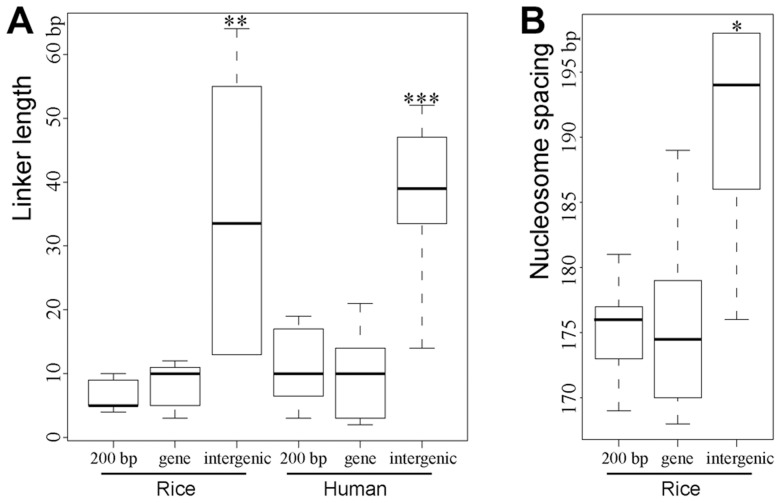
Boxplots of estimated lengths of linkers (A) and spacing (B) between the phased nucleosomes mapped close to DHSs."***","**","*" indicated p<0.001, p<0.01, p<0.05, respectively, for the comparison of linker length/spacing between intergenic region and either regions within genes (“gene”) or in proximal promoters (“200 bp”).